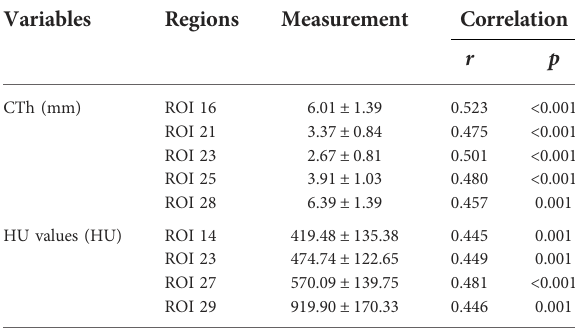
TABLE 2 Correlation between CTh and HU values of the proximal femur and hip